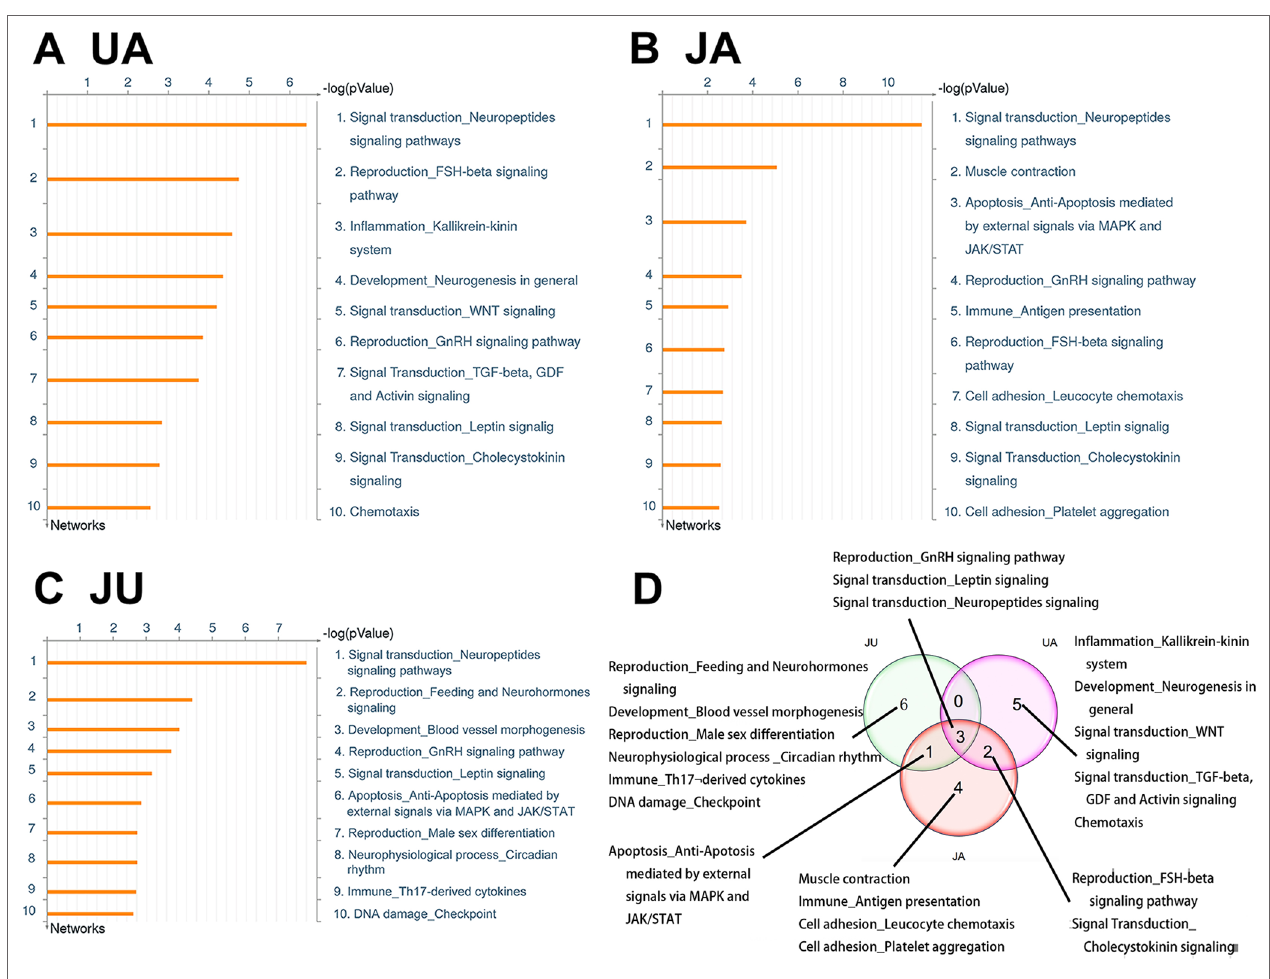
FIGURe 4 | The top 10 GeneGo processes in 3 treatment